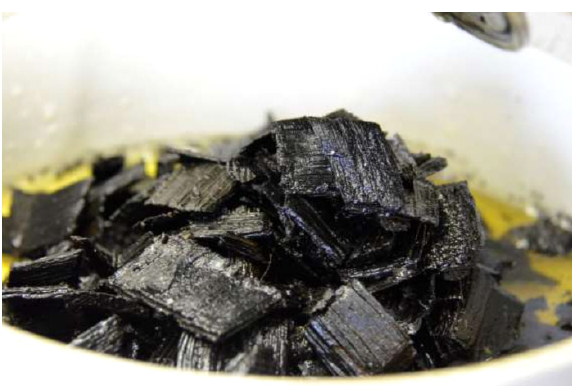
Figure 6. HTP catalyst biofuel from wood chips being separated from the catalyst solution using vacuum filtration.